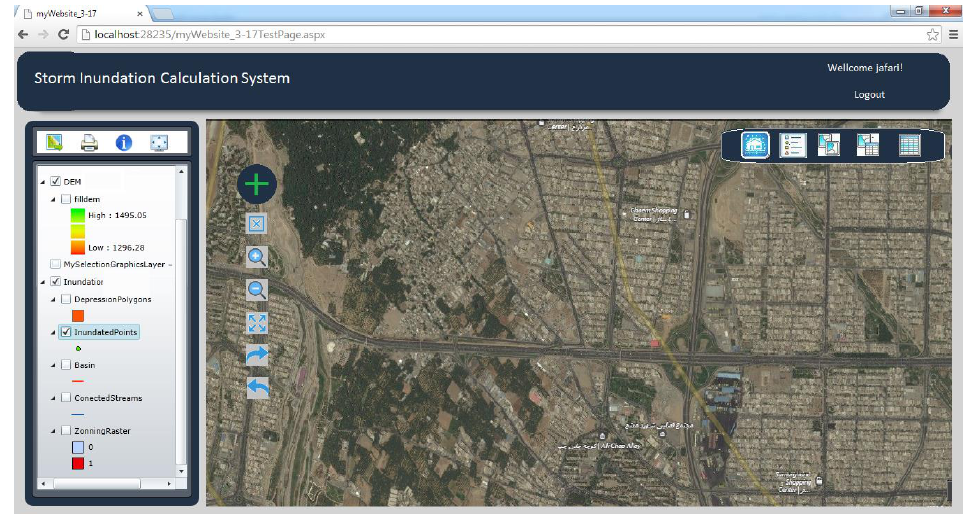
Figure 3. User interface of the developed web